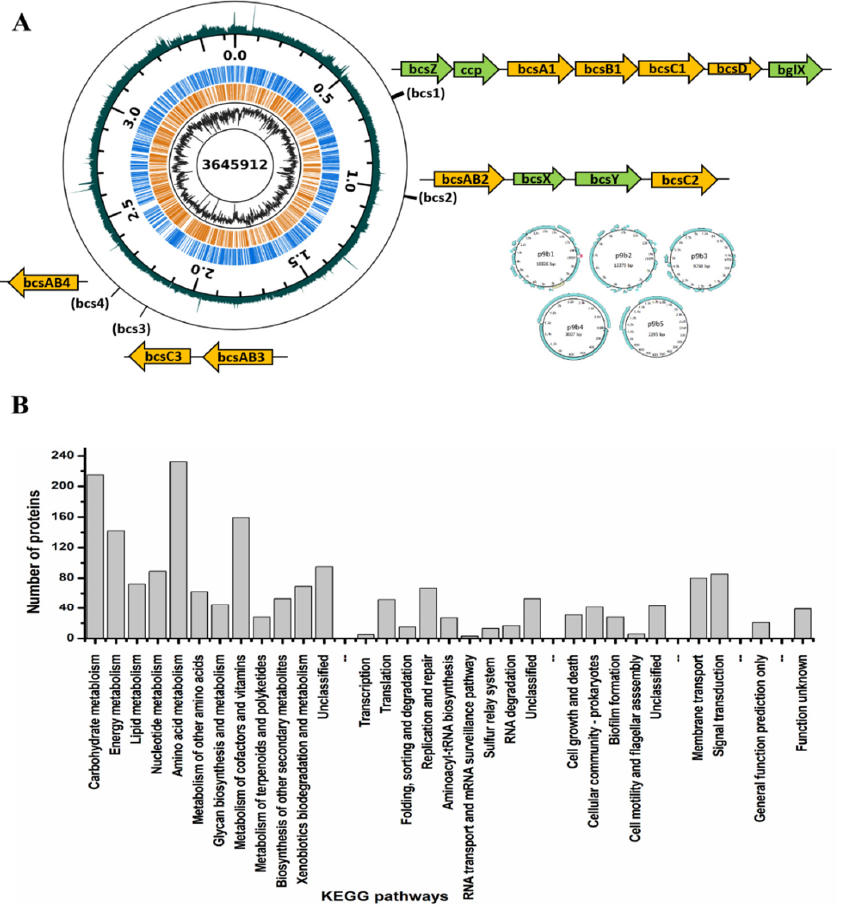
Figure 4. Overview of K. rhaeticus ENS9b genome. ( A ) Genome map. The K. rhaeticus ENS9b genome totals 3.69 Mbp (GC% of 63.05%), containing 3360 protein-coding gene predictions, 3 rRNAs, 1 tmRNA, 46 tRNAs and 3 non coding RNAs. A genome completeness of 100% was identified from CheckM. The genome consists of a chromosome of 3.65 Mbp (3302 predicted protein-coding regions). At least three putative plasmids; p9b1 (18.8 Kbp), p9b2 (13.4 Kbp), p9b3 (9.8 Kbp), were identified in K. rhaeticus ENS9b genome (( A ) inset). Although the replicon could not be determined, as similarly reported for other K. rhaeticus isolates [7,19], two putative plasmid sequences of sizes 3 Kbp (p9b4) and 2.3 Kbp (p9b5) were detected by plasmidSPAdes. Seven contigs (totaling 90 Kbp) could not be confidently placed in the genome. The displayed data from center to perimeter are: chromosome size (bp), GC-percentage, CDSs on the reverse strand (in the middle, orange), CDSs on the forward strand (in the middle, blue), chromosome position (major ticks 500 kbp, minor ticks 100 kbp), and coverage (outermost). Both GC-percentage and coverage were calculated with 1 kbp window size. GC-percentage ranged from 33.6% to 75.5% and coverage (number of reads mapping to the locus) from 380 to 49600. Coverage is displayed with logarithmic scaling. The bcs operon (orange filled arrows) and the flanking accessory genes (green filled arrows) indicated in the manually curated figures directs to their position in the genome. ( B ) KEGG classification and functional categorization .